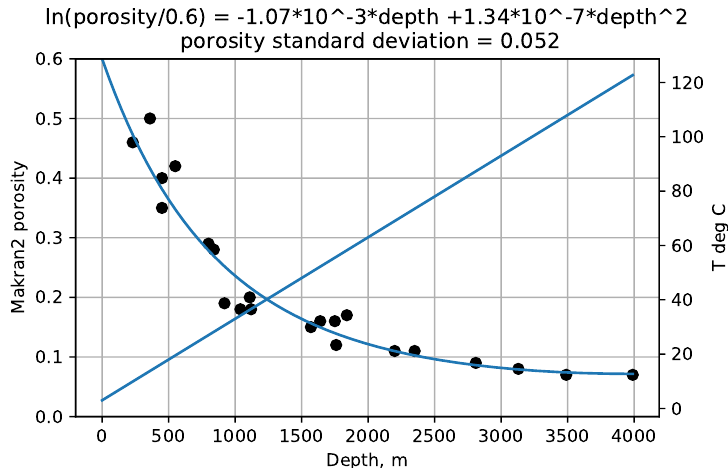
Figure 3. Makran2 porosity trend.